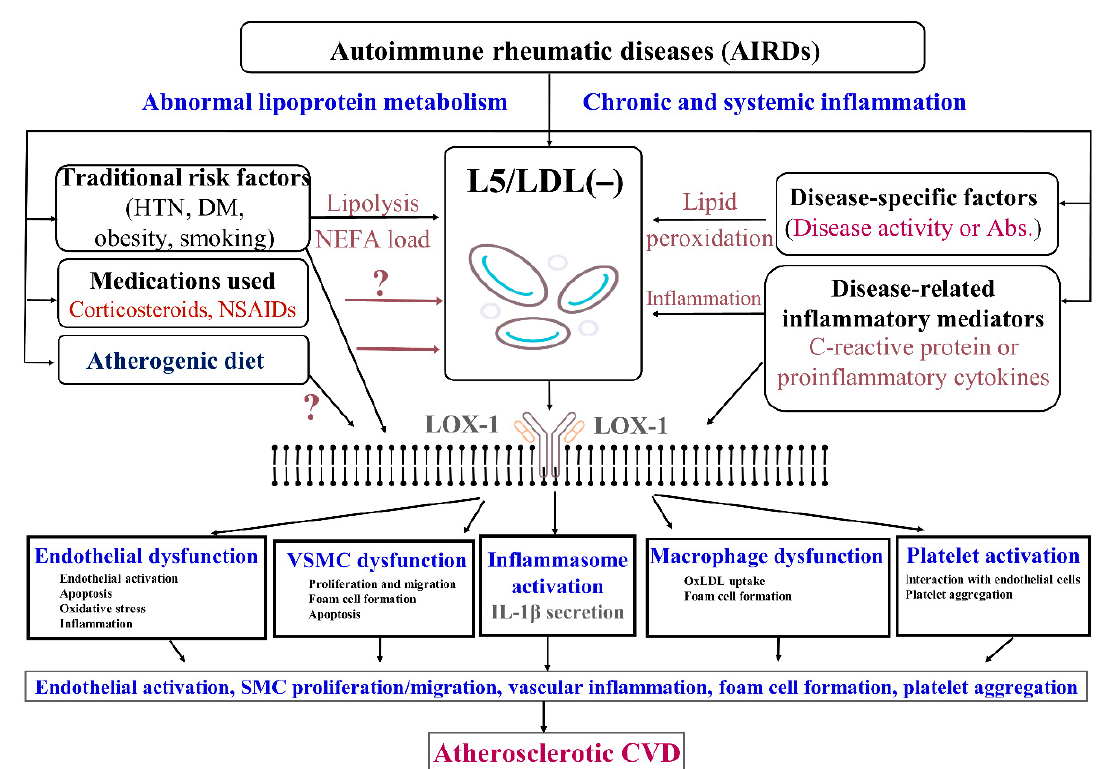
Figure 1. The probable atherogenic role of electronegative LDL (LDL( − )/L5) in patients with AIRDs. The increased levels of LDL ( − ) may be produced by lipolysis with non-esterified fatty acid (NEFA) loading in patients with diabetes. Cigarette smoking is associated with L5 formation and LOX-1-induced atherosclerosis. C-reactive protein induces LOX-1 expression. L5/LDL ( − ) and the LOX-1 signaling pathway lead to atherogenesis, vascular inflammation, and platelet activation/aggregation. LDL: low-density lipoprotein; LOX-1: lectin-like oxidized low-density lipoprotein receptor 1; HTN: hypertension; DM: diabetes mellitus; NSAIDs: nonsteroidal anti-inflammatory drugs; Abs.: autoantibodies; oxLDL: oxidized LDL; IL-1 β : interleukin 1 β ; CVD: cardiovascular disease.